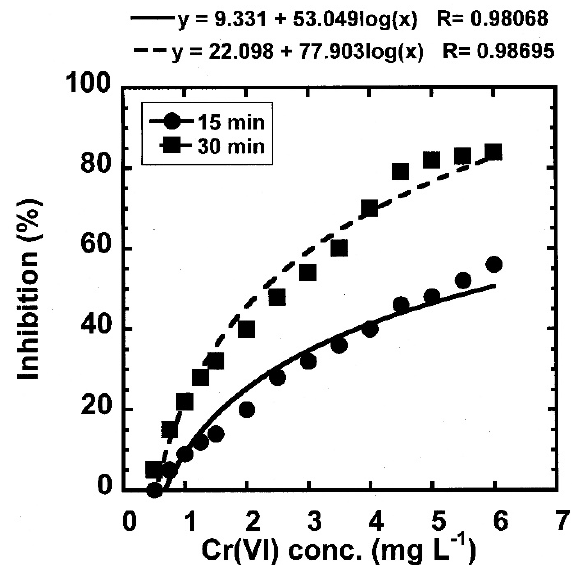
Figure 6. Determination of the toxicity of chromium (VI) ions in a 15 min and 30 min test with luminescent bacteria. The appropriate log regression curves are indicated.